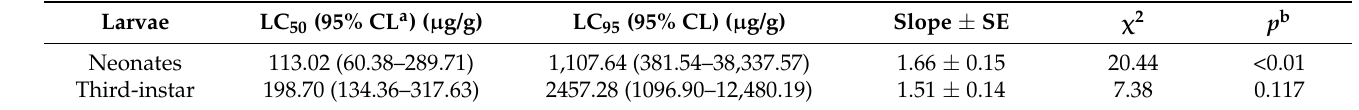
Table 1. Insecticidal activity of CsA against O. furnacalis larvae 7 days after